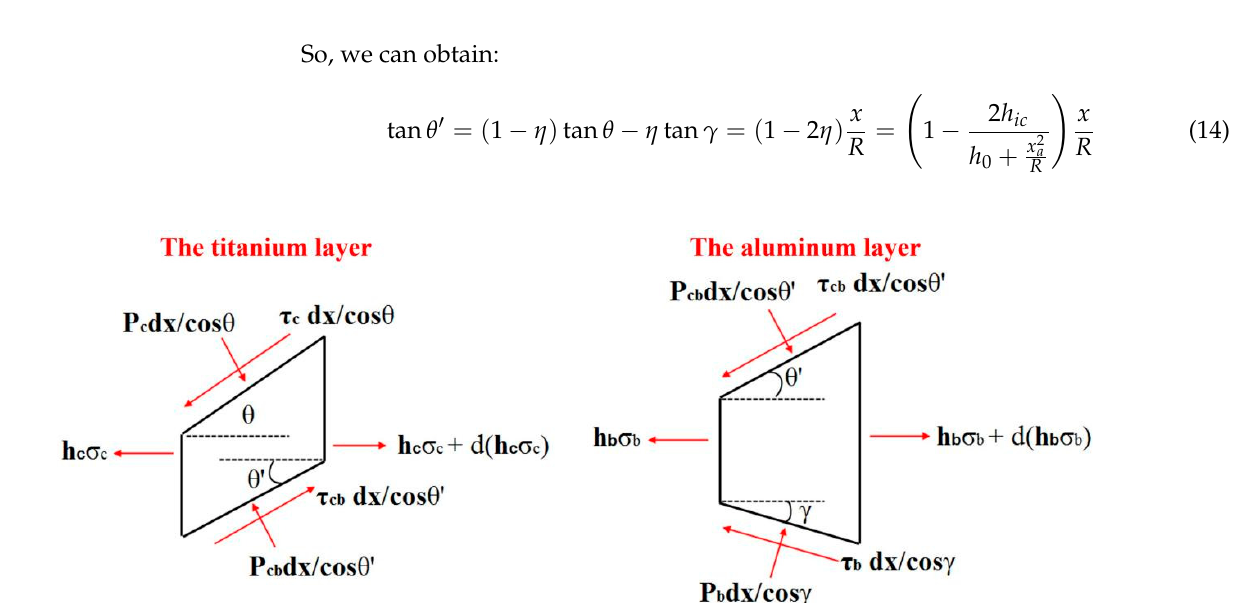
Figure 3. Stress state of micro-element in region II.